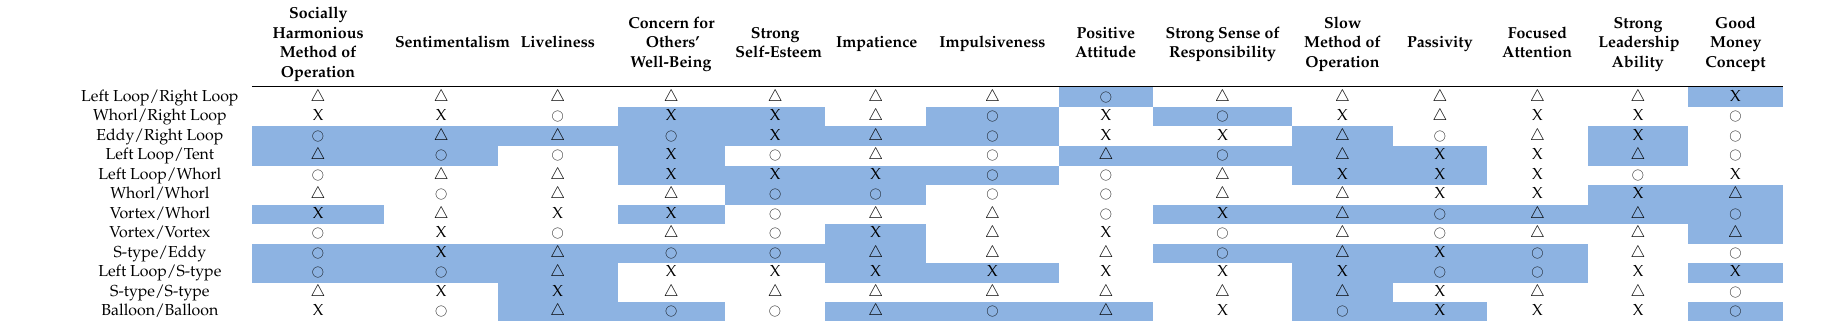
Table 5. Relationship between fingerprint type and personality